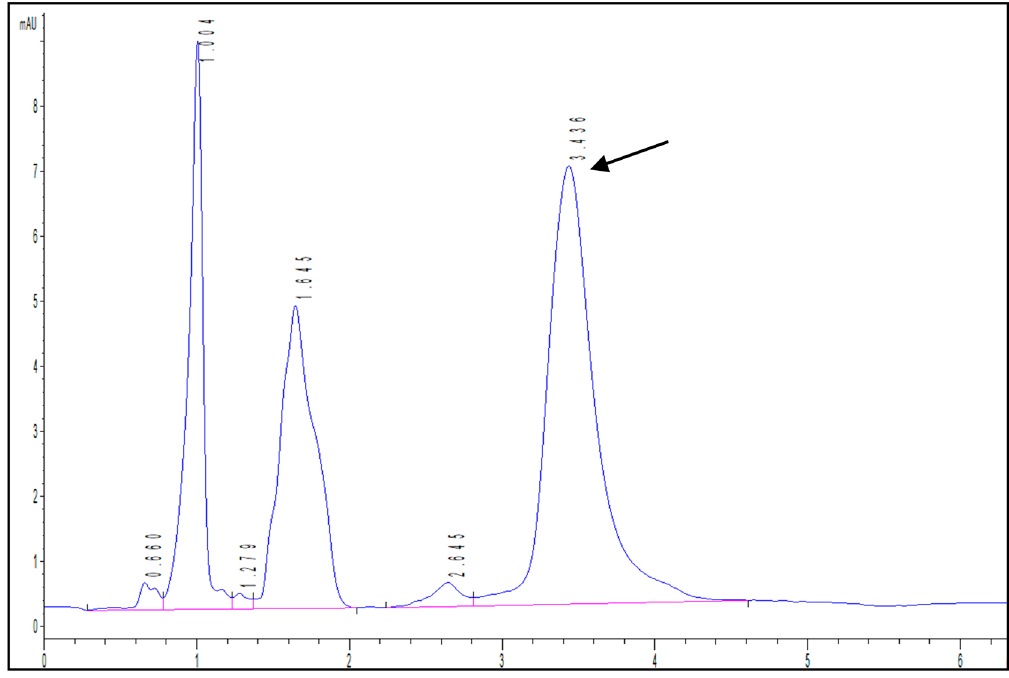
Figure 4. Example of HPLC-DAD chromatogram showing the peak corresponding to isopropyl palmitate (retention time = 3.436 min).